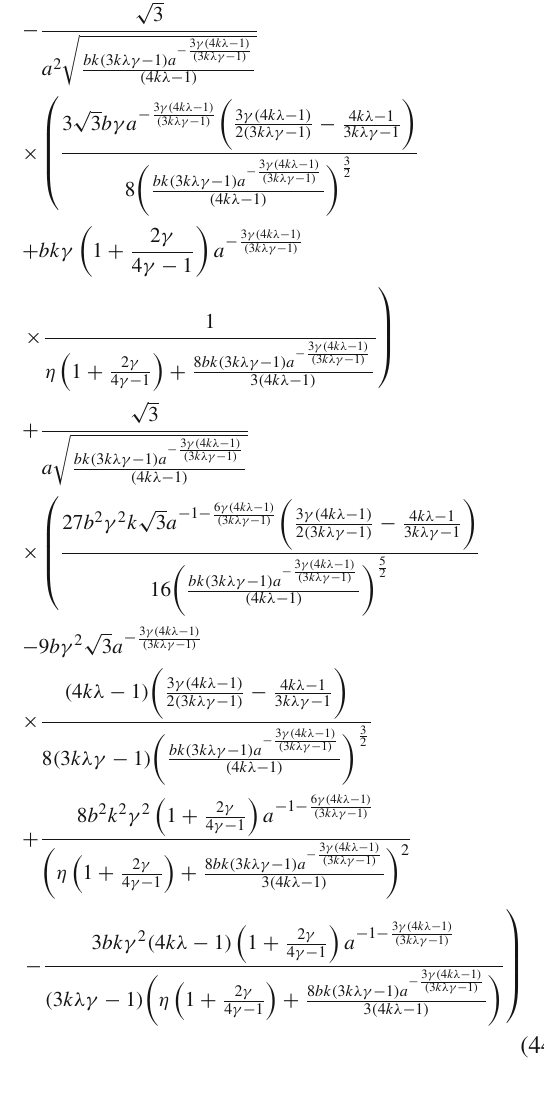
is positive while Fig. 6 provide the validity of thermo- dynamical equilibrium for all values of γ with negative decreasing value of β . • Power law corrected entropy In this entropy, we have analyzed that the first law of thermodynamics holds (Fig. 7) as well as the GSLT is valid for all values γ